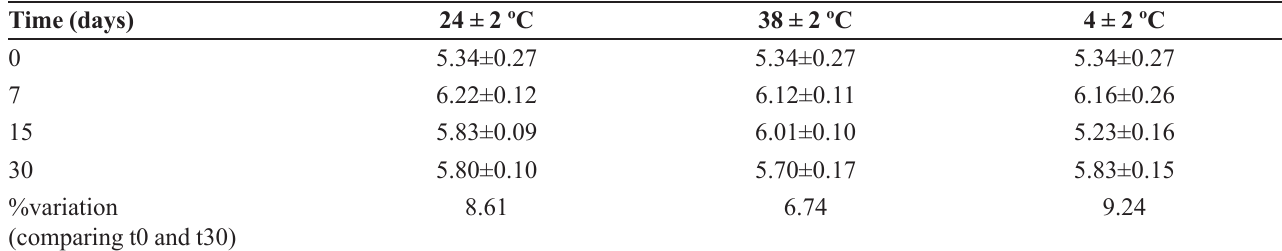
TABLE II - pH values determined during 30 days in the formulation without the GB soft extract (mean ± standard deviation). The percentage of variation comparing t0 and t30 is shown Time